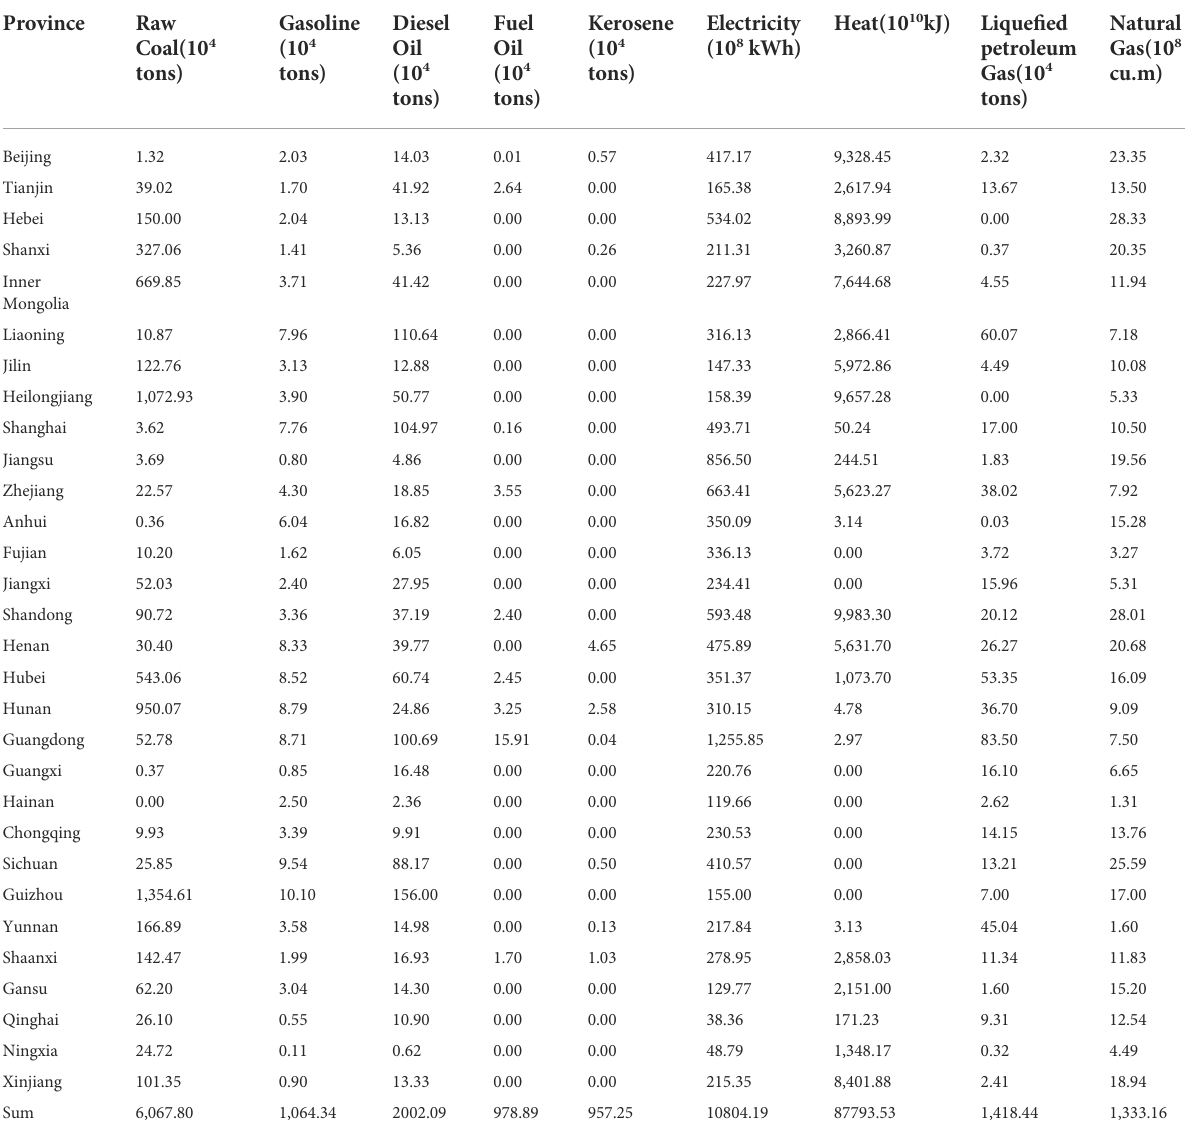
TABLE A1 The energy consumption of public buildings in